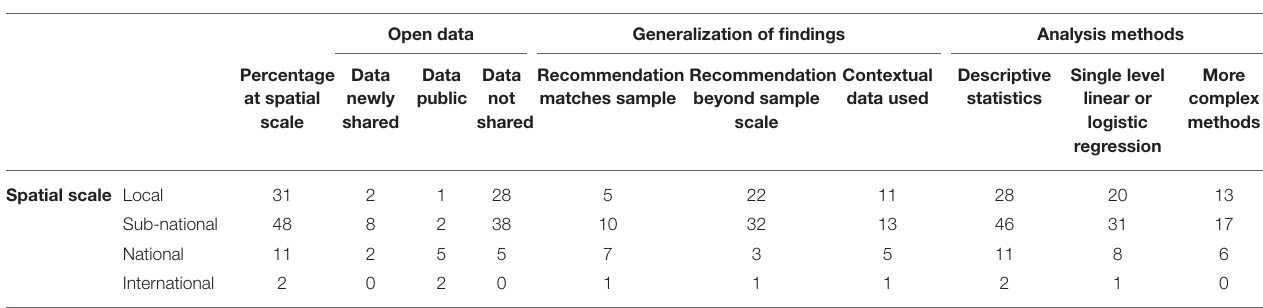
TABLE 8 | Cross tabulations of articles’ scale and the